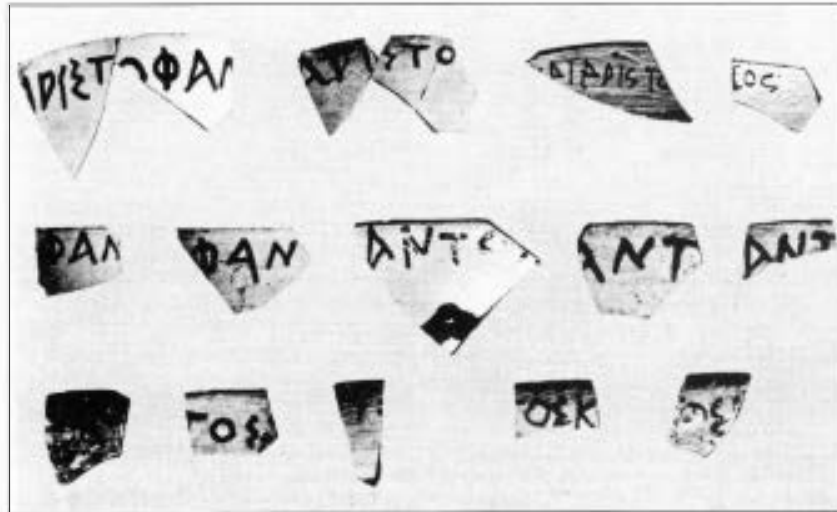
Figure 3 Some of the Chi an cups dedicated by the trader Aristophantos at the sanctuary of Aphaia on Aegina, c. 550 BC.